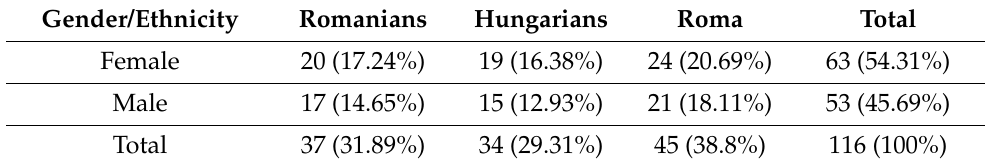
Table 1. Distribution of the study group according to gender and ethnicity.